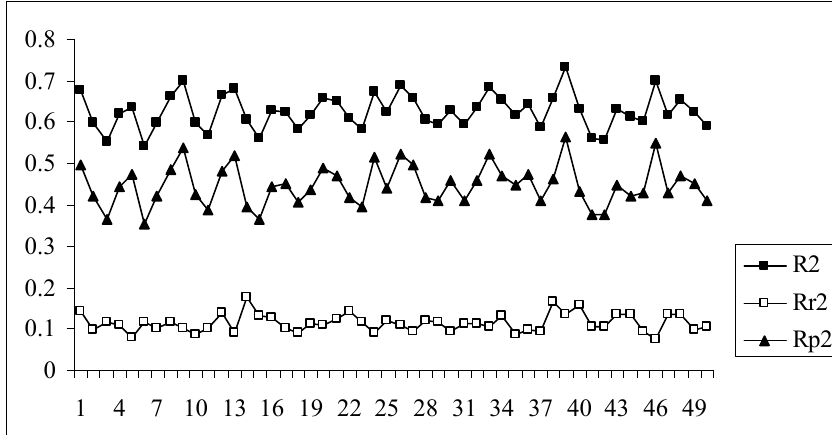
Figure 4. Comparative plots of R 2 , R r2 and R p2 values of 50 models (data set